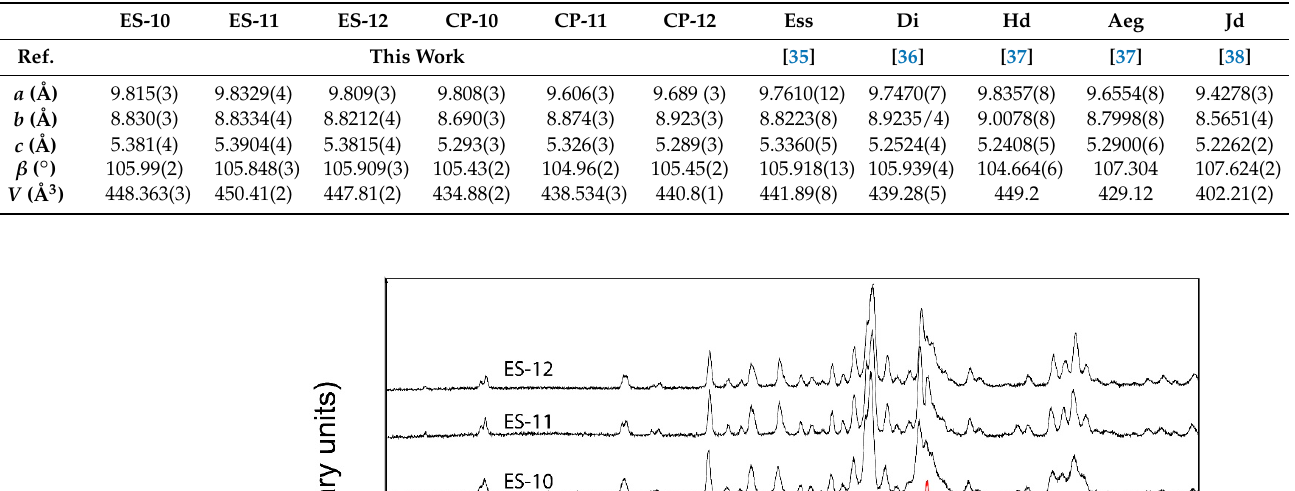
Table 6. Unit-cell parameters of pyroxene as a breakdown product after the heat treatment of epidote (ES) and clinozoisite (CP) compared to esseneite (Ess), diopside (Di), hedenbergite (Hd), aegirine (Aeg), and jadeite (Jd).